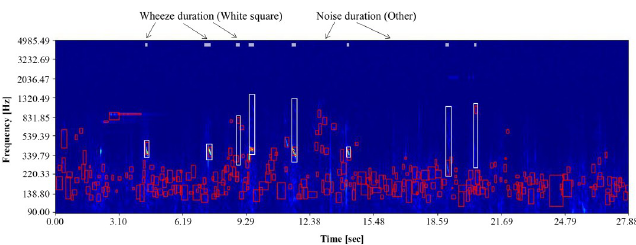
Fig 3. Consecutive maximum values detected on a spectrogram in step 4 of a newly developed wheeze recognition algorithm for children.